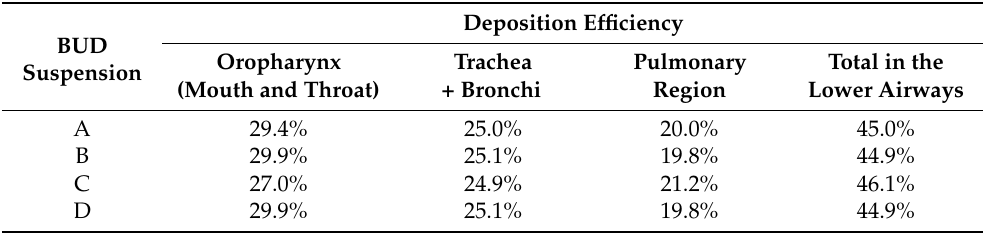
Table 6. Calculated deposition of inhaled aerosol droplets in different regions of the respiratory system (MPPD model, standard inhalation conditions via